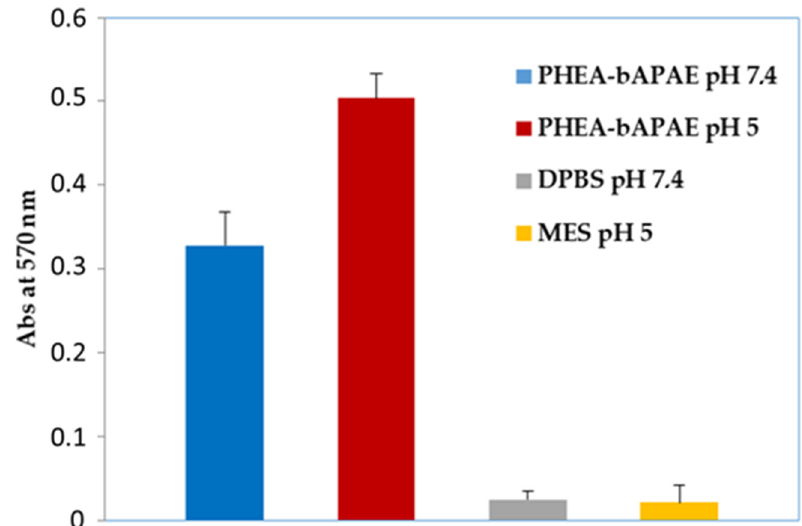
Figure 7. Destabilization assay: absorbance values at 570 nm (trypan blue) in 16 ‐ HBE cell dispersion after incubation with PHEA ‐ g ‐ bAPAE copolymer at different pH values.